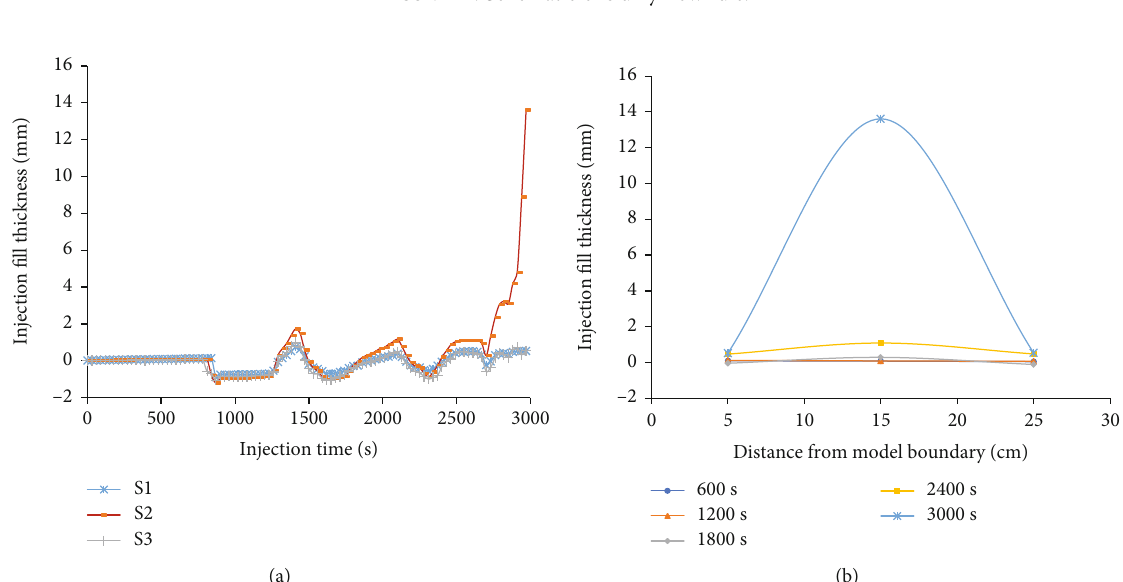
Figure 13: Distribution of injection fi ll. Fill thickness as a function of (a) time and (b)